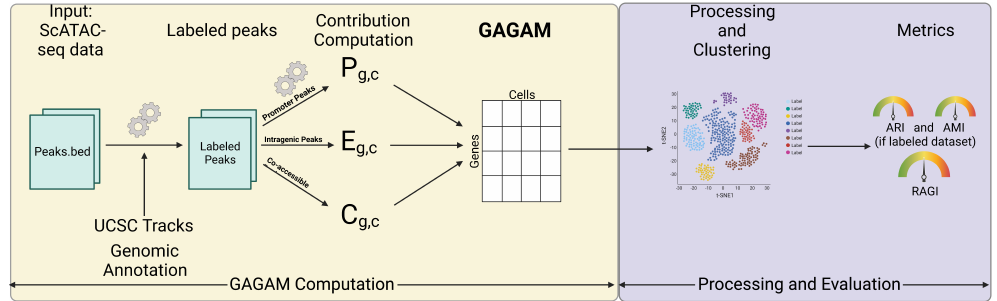
Figure 1. Workflow for computation and evaluation of GAGAM. The workflow starts with scATAC- seq data, and labels the peaks with the help of genomic annotations and UCSC tracks. Then it computes the three contributions forming GAGAM. GAGAM is evaluated and compared to other GAMs through clustering experiments with three well-established metrics: ARI [29], and AMI [30] (if the dataset is labeled) or RAGI [31] (if the dataset is not labeled).